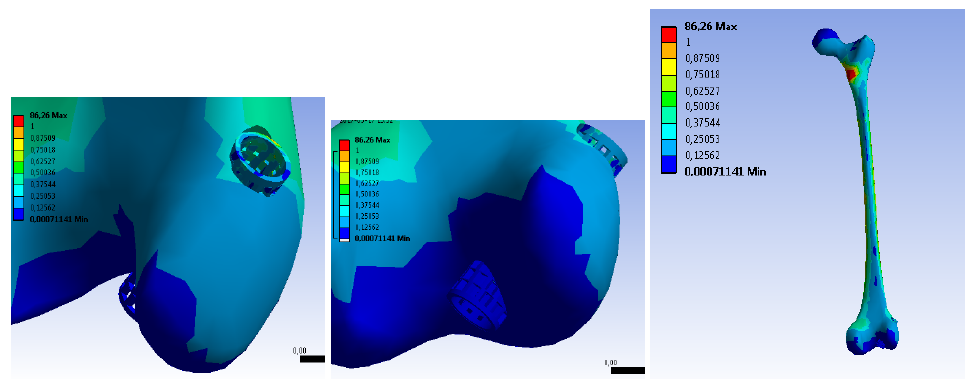
Figure 23. Stress in spongy tissue and implant (scale